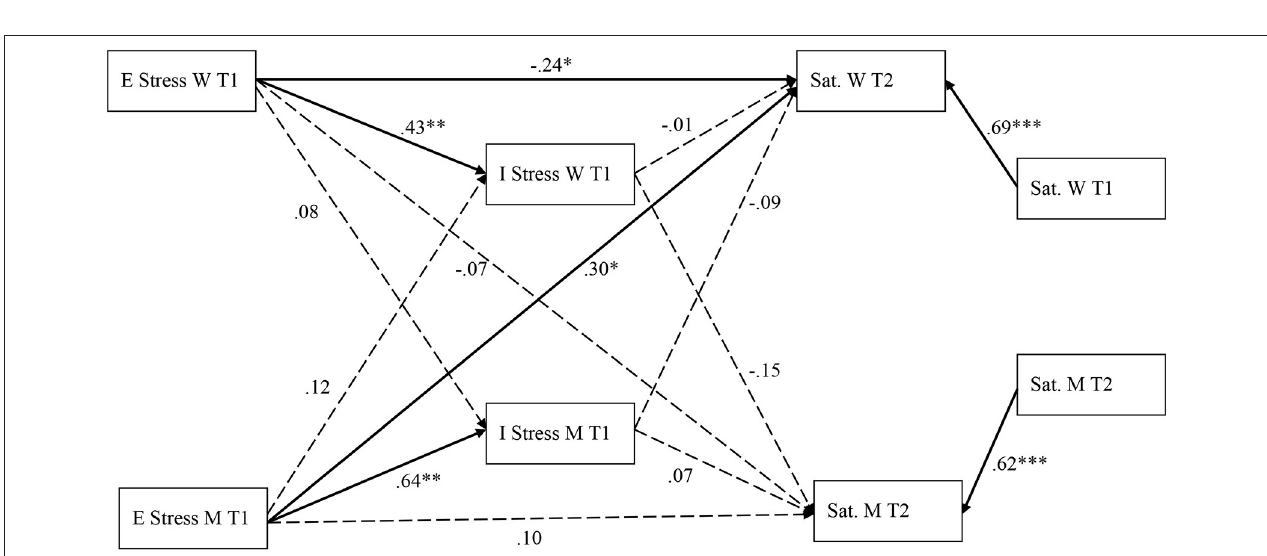
FIGURE 2 | Standardized path estimates for the high SES group ’s mediation model. *** p < 0.001, ** p < 0.01, * p < 0.05; E Stress, External stress; I Stress, Internal stress; Sat, marital satisfaction; W, women; M, Men. Bolded arrows represent significant paths. Dashed arrows represent non-significant